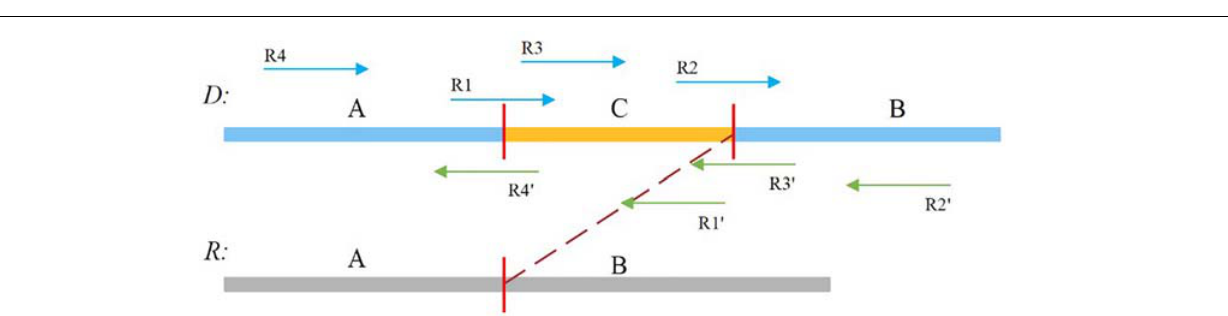
FIGURE 1 | The process of Sins.